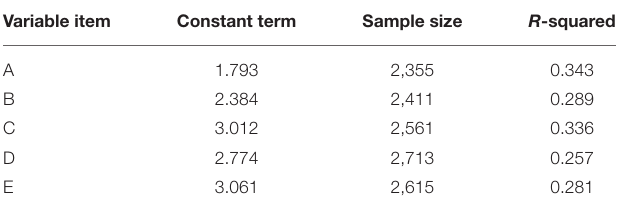
TABLE 2 | Analysis of operating elements of social mobile games.